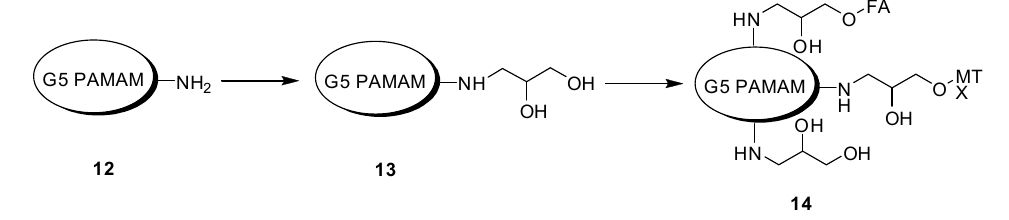
Figure 17. “One pot” reaction to obtain targeted prodrugs [71].